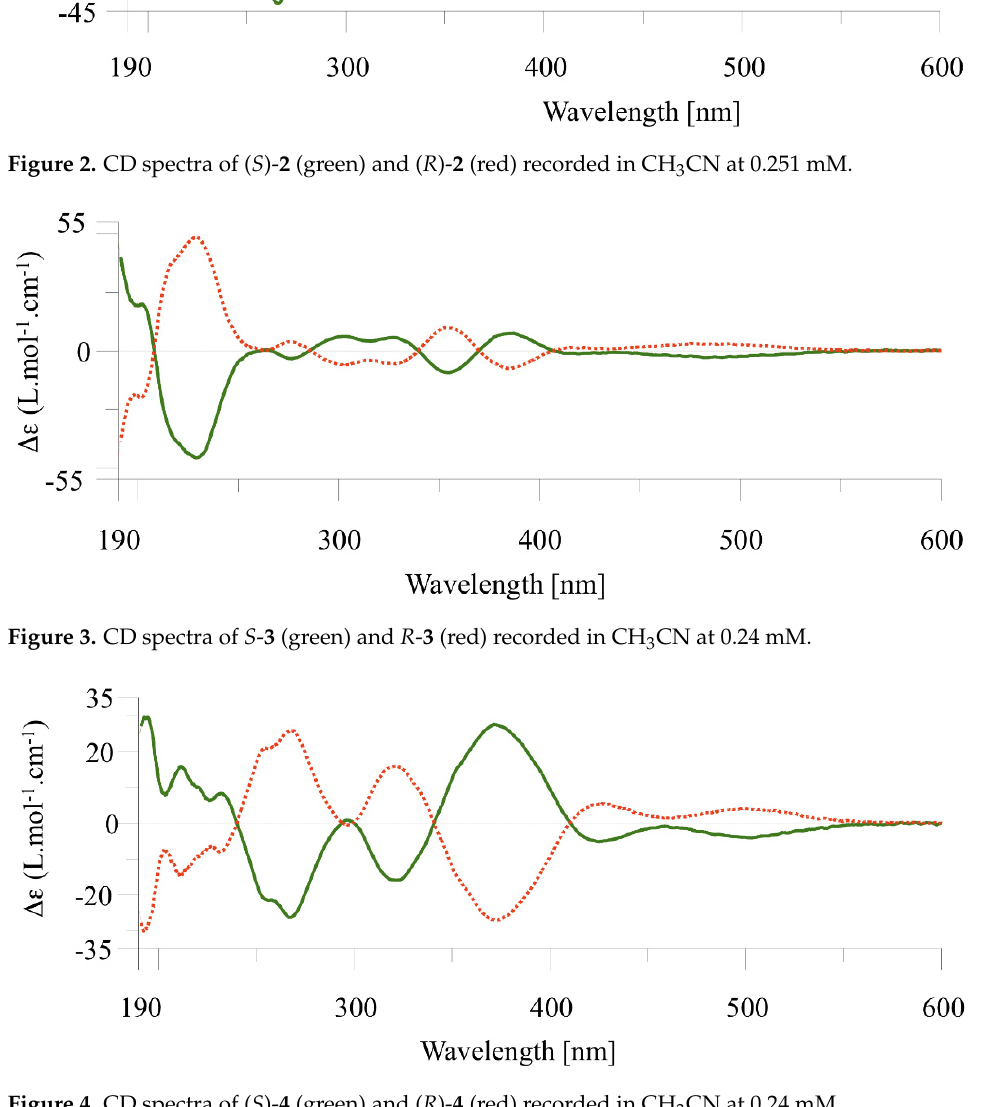
Figure 4. CD spectra of ( S )- 4 (green) and ( R )- 4 (red) recorded in CH 3 CN at 0.24 mM.